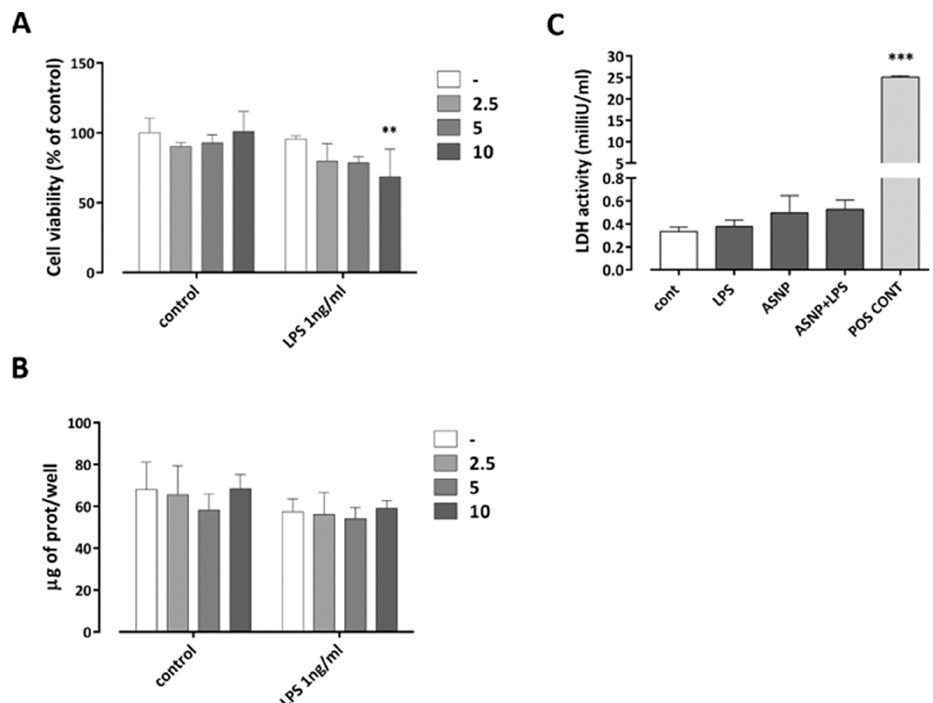
Figure 1. ASNP toxicity on human macrophages. Monocytes were isolated and differentiated as described in Materials and Methods. Macrophages were then exposed to increasing doses (2.5 up to 10 µ g/cm 2 ; ( A , B )) or to 10 µ g/cm 2 ( C ) of ASNP for 48 h. In the last 24 h, incubation was performed in the presence or in the absence of LPS (1 ng/mL). After the experimental treatments, cell viability ( A ) and protein content ( B ) were determined. Culture medium was conserved for the LDH activity assay ( C ). Data of cell viability and protein abundance are means of three independent determinations ± SD in two experiments, while LDH values are means of six independent determinations ± SD in two experiments. Positive control ( C ); medium of cells incubated in the presence of Triton-X100 0.01% for 15 min. ** p < 0.01 vs. LPS 1 ng/mL without ASNP; *** p < 0.001 vs. control, two-way ANOVA. In ( A , C ), Sidak multiple comparison post hoc test was